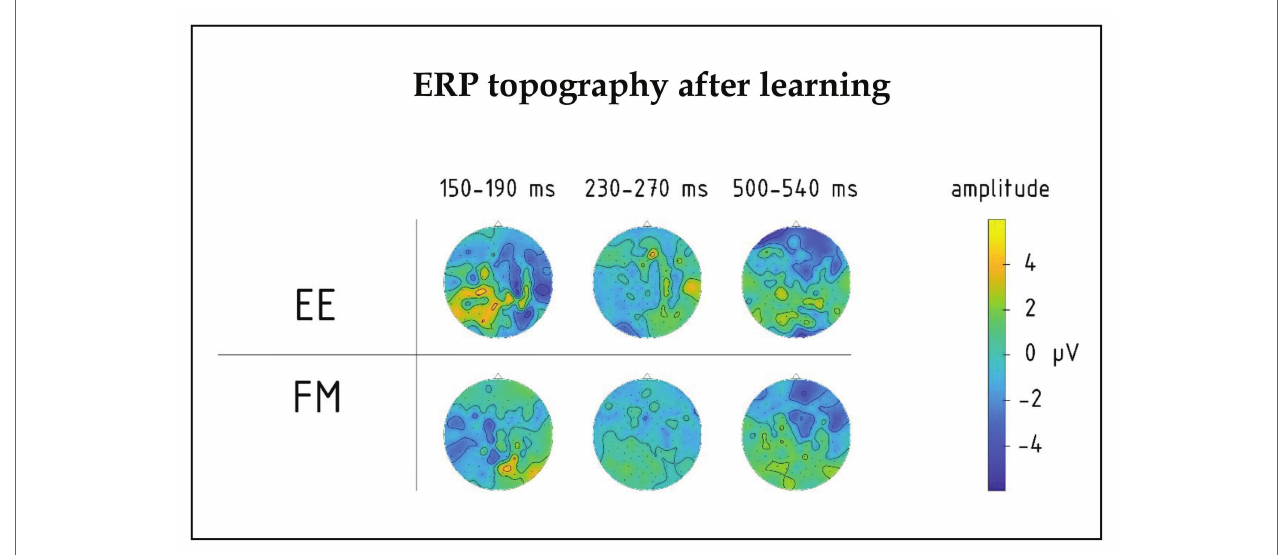
FIGURE 4 | Topography of group average ERPs to newly learnt words in the 150–190, 230–270, and 500–540 ms intervals for FM and EE conditions after learning. Significant interactions involving learning type (FM vs. EE) were found in the first and third intervals, but not the second